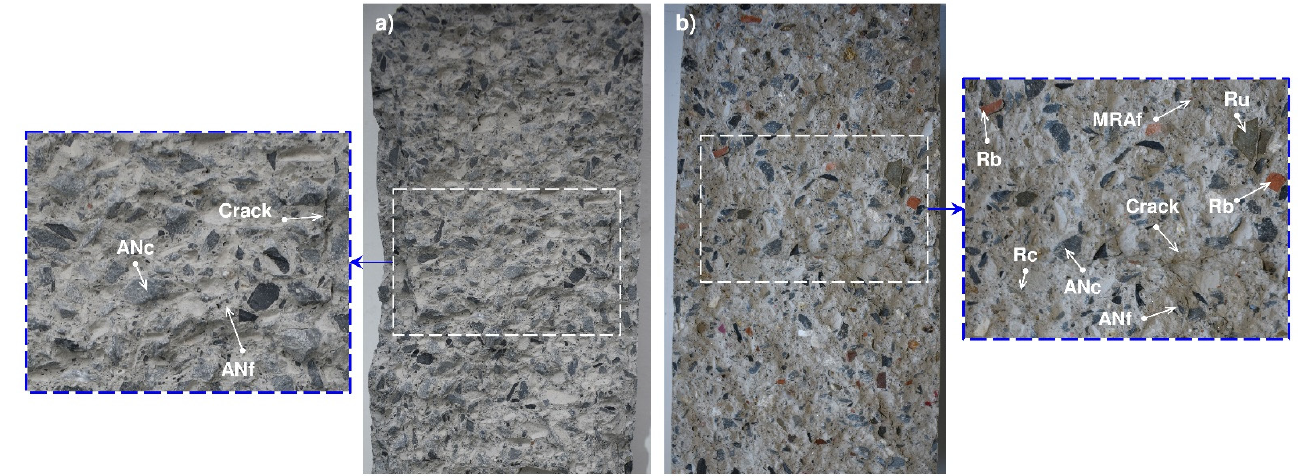
Figure 8. Appearance of the concretes when performing the tensile test 28 days after producing the mortar: ( a ) conventional concrete (M1) and ( b ) concrete with 50% cMRA + 50% fMRA (M9).